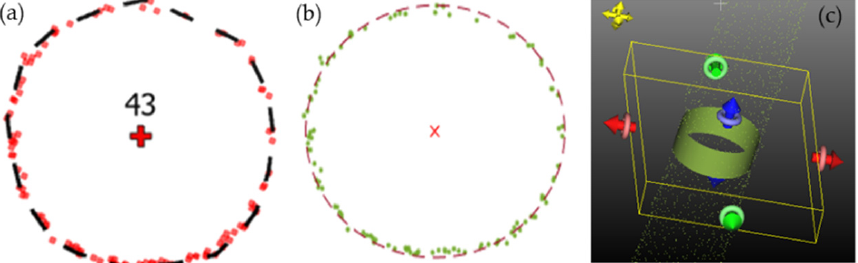
Figure 4. An example of the same cross-sectional profile and the different fitting methods at diameter at breast height (DBH) using ( a ) convex hull (the red points represent the TLS data, and the dashed black line represents the convex hull circumference), ( b ) circle fitting (green points represent the TLS data; the dashed red line represents the circle fitting circumference), and ( c ) RANSAC.